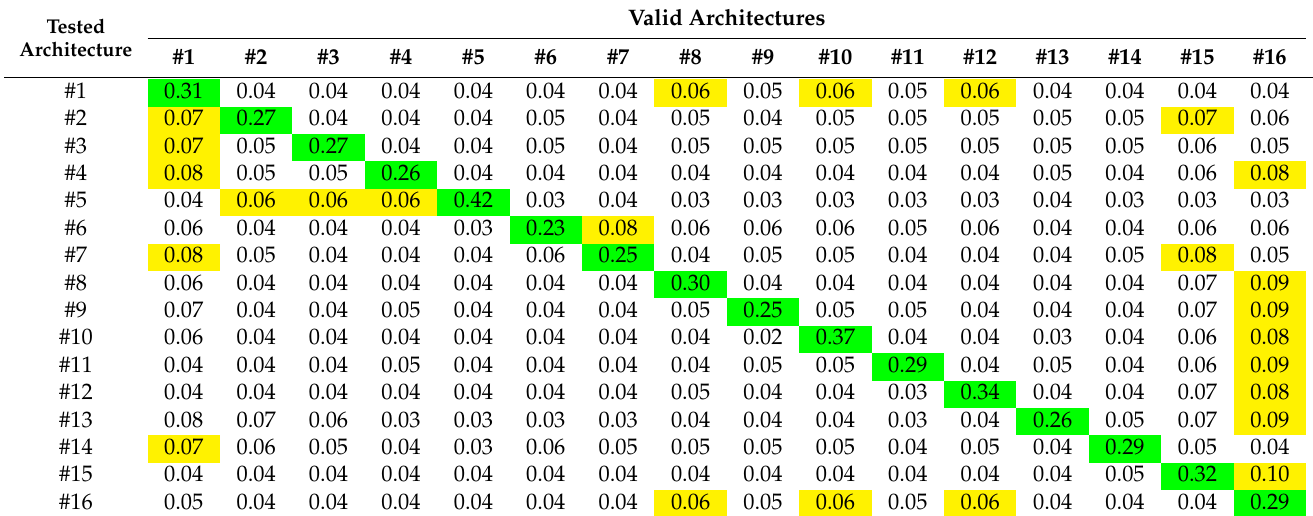
Table 3. Probabilities of assigning tested files to